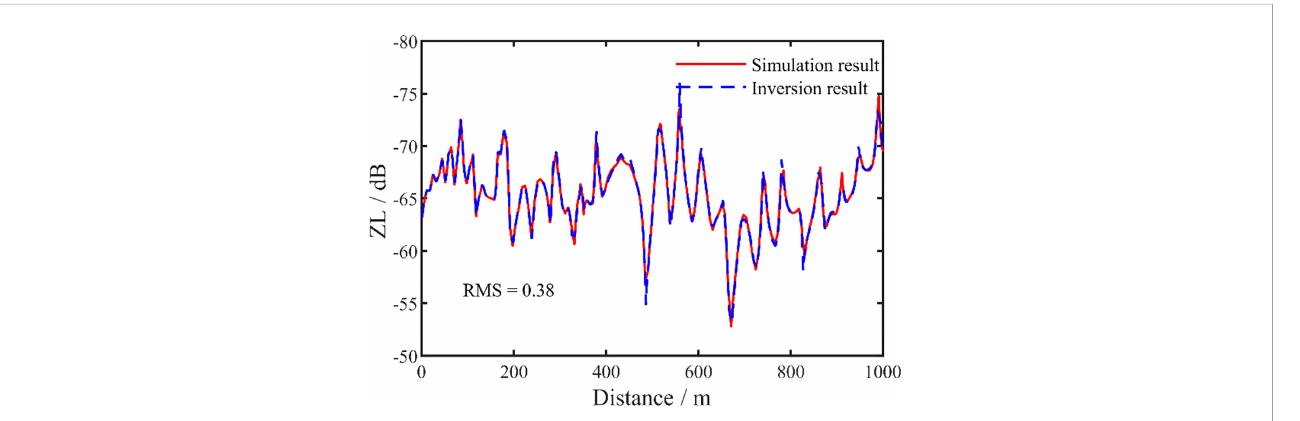
FIGURE 6 Comparison of the vertical waveguide characteristic impedance inversion results of simulation data. The inversion result is the dashed line and the experimental data is the solid line.